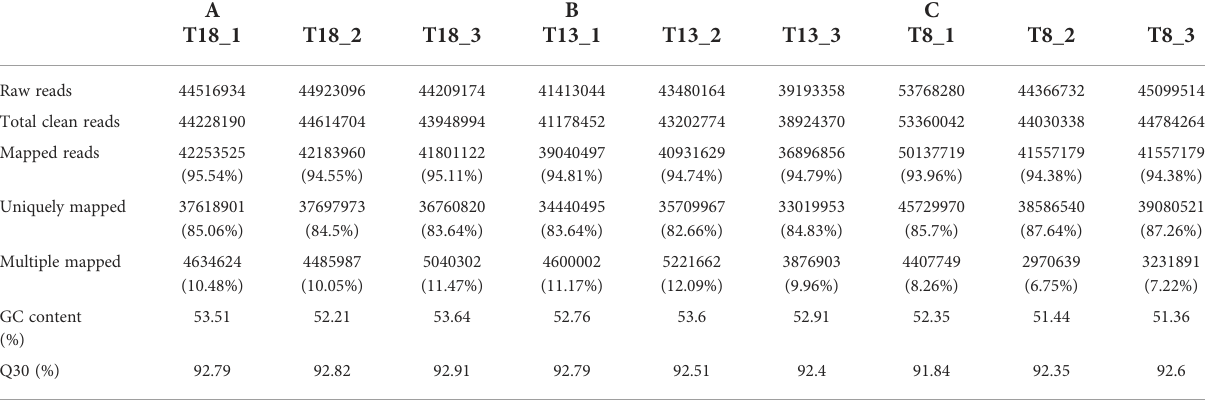
TABLE 2 Results of sequencing data statistics and comparison with the reference genome.